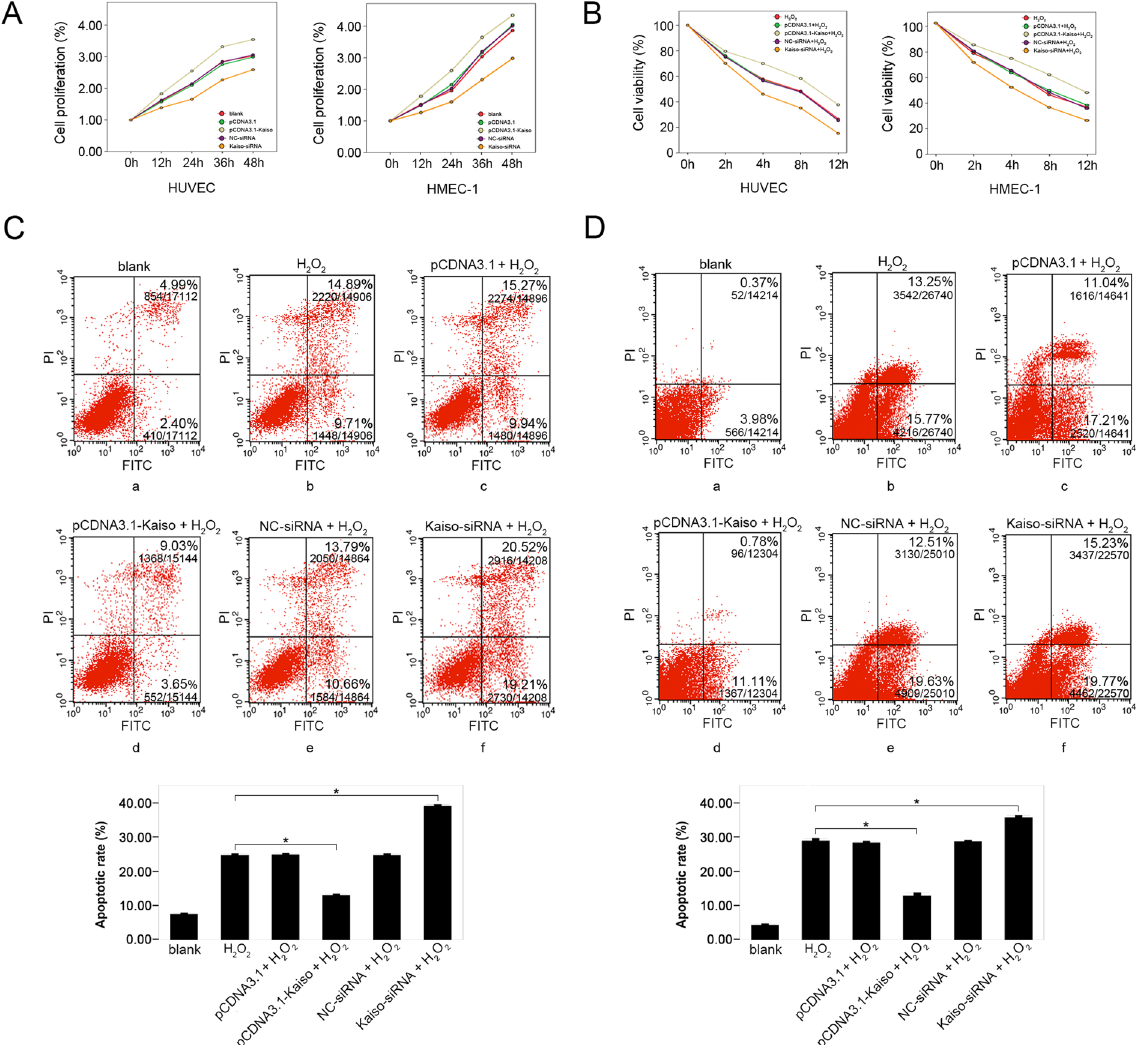
Figure 3. Anti-apoptotic effect of Kaiso in H 2 O 2 treated endothelial cells. Cells were transfected with pCDNA3.1, pCDNA3.1-Kaiso, NC-siRNA or Kaiso-siRNA and cell viability was analyzed at 0, 12, 24, 36, and 48 h after transfection using CCK8 method ( A ). Cells were transfected with pCDNA3.1, pCDNA3.1-Kaiso, NC- siRNA or Kaiso-siRNA and were cultured at 37 °C for 48 h. Then, cells were treated with 400 μ M H 2 O 2 for 0, 2, 4, 8, and 12 h and cell viability was analyzed at the end of each time period using CCK8 method ( B ). HUVECs ( C ) and HMEC-1s ( D ) were transfected with pCDNA3.1, pCDNA3.1-Kaiso, NC-siRNA or Kaiso-siRNA and were cultured at 37 °C for 48 h. Cells were then treated with 400 μ M H 2 O 2 for 8 h and cell apoptosis was examined using Annexin V/Propidium iodide (PI) flowcytometry analysis. The untreated cells served as a blank. Values are presented as mean ± SD, * p < 0.01, compared with H 2 O 2 group, n =